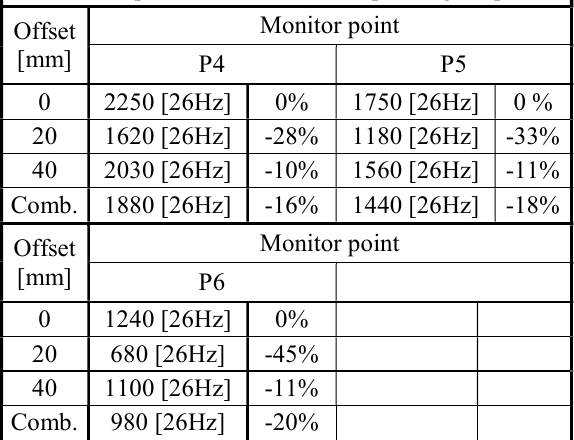
Fig. 10 Amplitude-frequency characteristics calculated from point 4 for static pressure (at 90% height of turbine chamber)